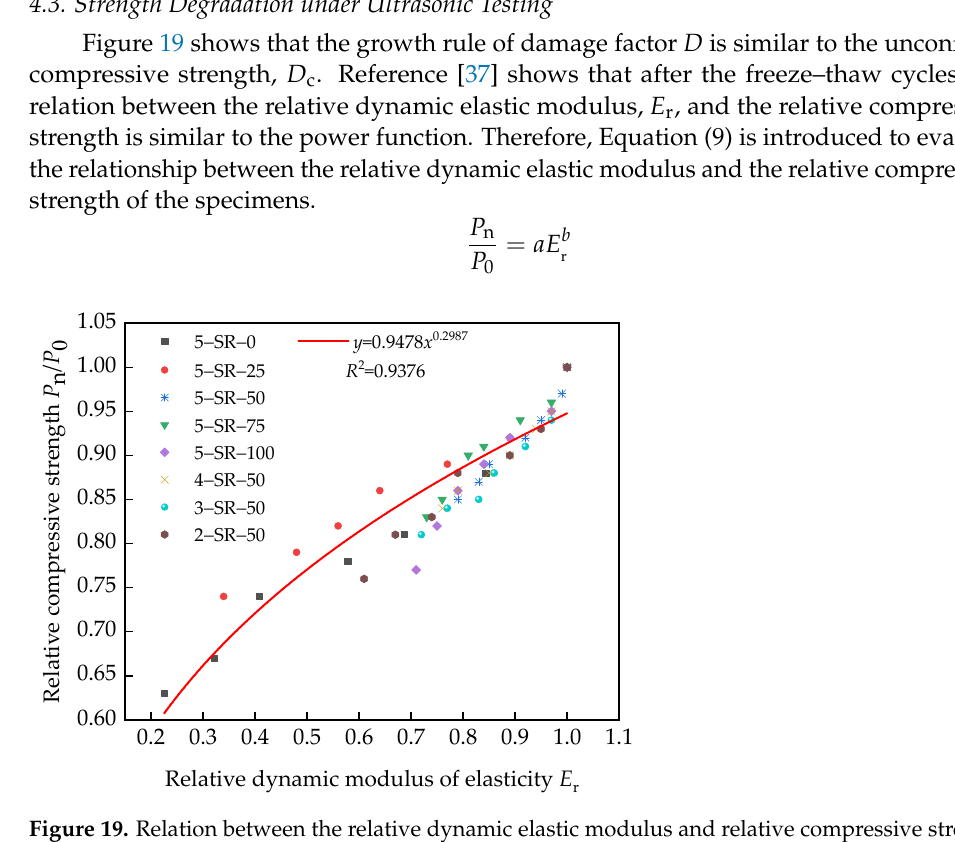
Figure 19. Relation between the relative dynamic elastic modulus and relative compressive strength of specimens.